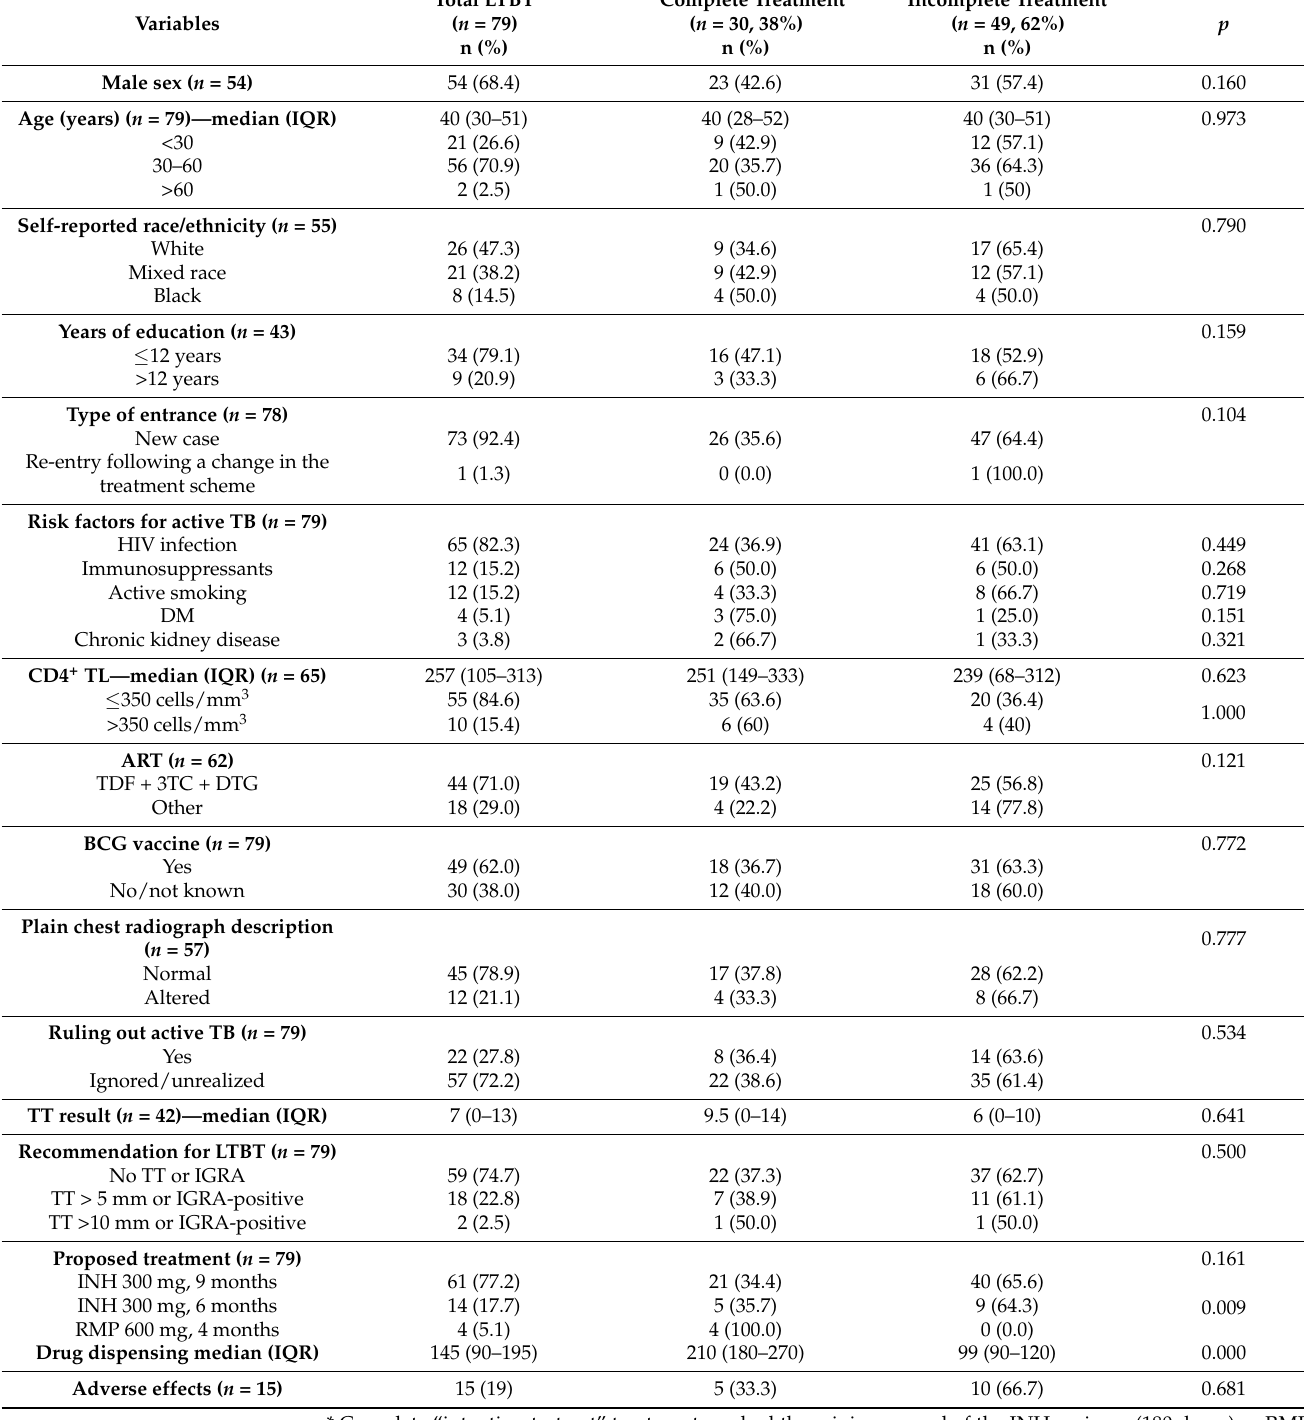
Table 1. Clinical and epidemiological characteristics, examinations, therapeutic regimens, and outcomes of patients notified of an LTBT diagnosis in a Brazilian tertiary center from 2017 to